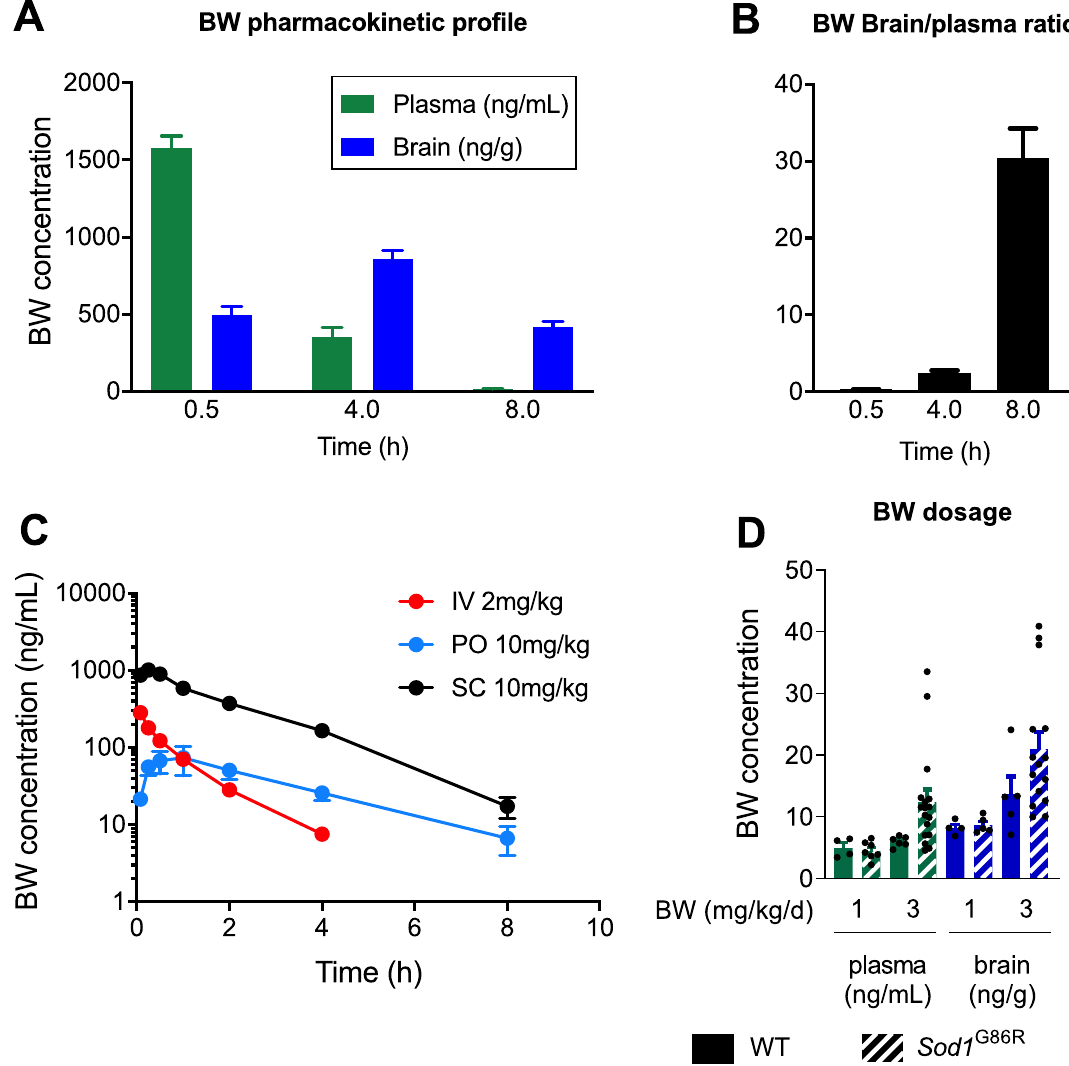
Figure 1. BW dosage and pharmacokinetic profile. ( A ) Kinetic concentration of BW in plasma and brain after a single IP injection of BW at 10 mg/kg. ( B ) Brain to plasma ratio of data presented on graph ( A ) ( C ) PK profile of BW after administration per os (PO), intravenous (IV) or subcutaneous (SC) in CD-1 mice. ( D ) Plasma and brain concentration of BW from our study animals treated with either 1 or 3 mg/kg/d.